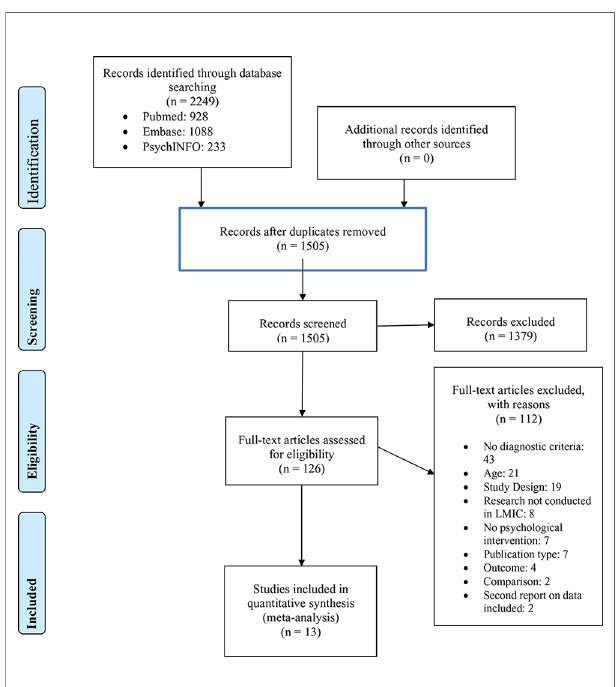
FIGURE 1 | PRISMA fl ow